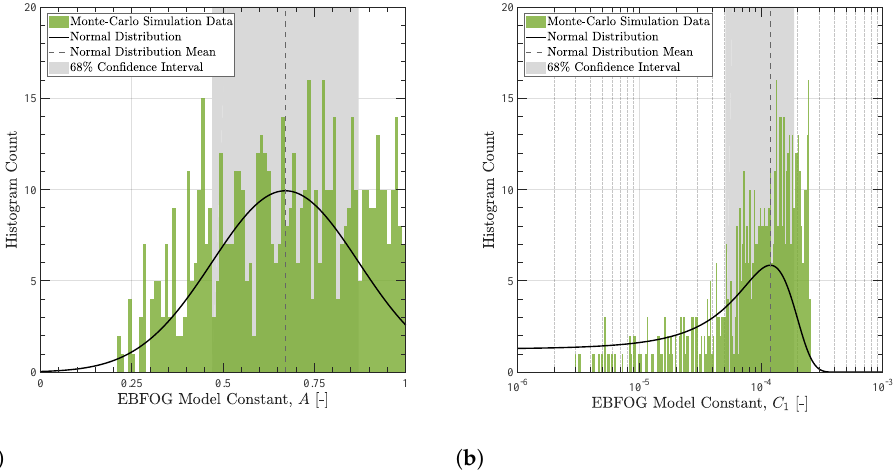
Figure 9. Histogram of outputs showing the distribution of input values for the empirical constants A ( a ) and C 1 ( b ) that resulted in a simulation predicting both EGT rise and HP speed reduction that fall within the ranges observed during the Galunggung encounter event. The predicted mean value from the simulations carried out and the confidence interval for this prediction are also